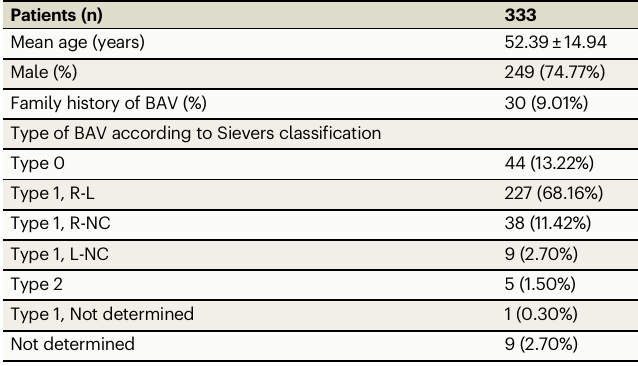
Table 1 | Baseline patient characteristics in 333 patients with bicuspid aortic valve Patients